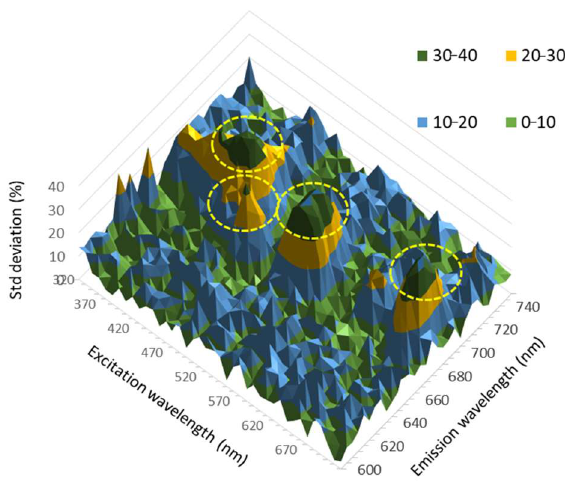
Figure 3. Fluorescence spectrum with excitation light scanned from 320 nm to 700 nm of ( a ) of Nan-